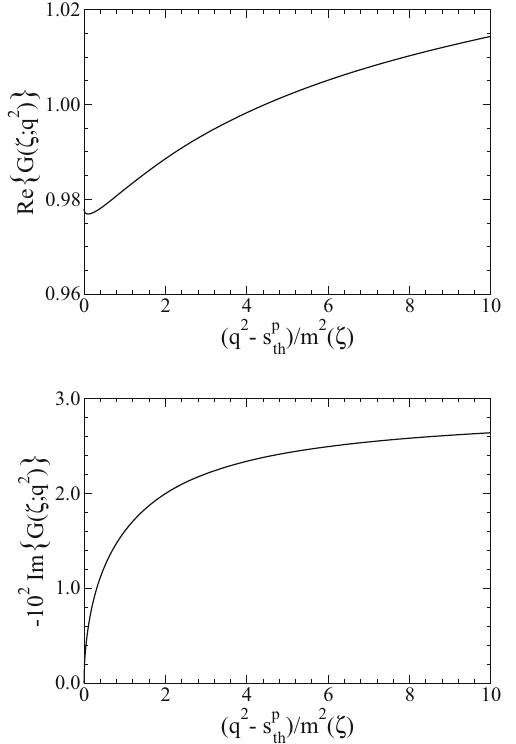
Fig. 5 The same as in Fig. 4, but in the timelike region. Upper panel: realpartoftherunningmass.Lowerpanel:imaginarypartoftherunning mass